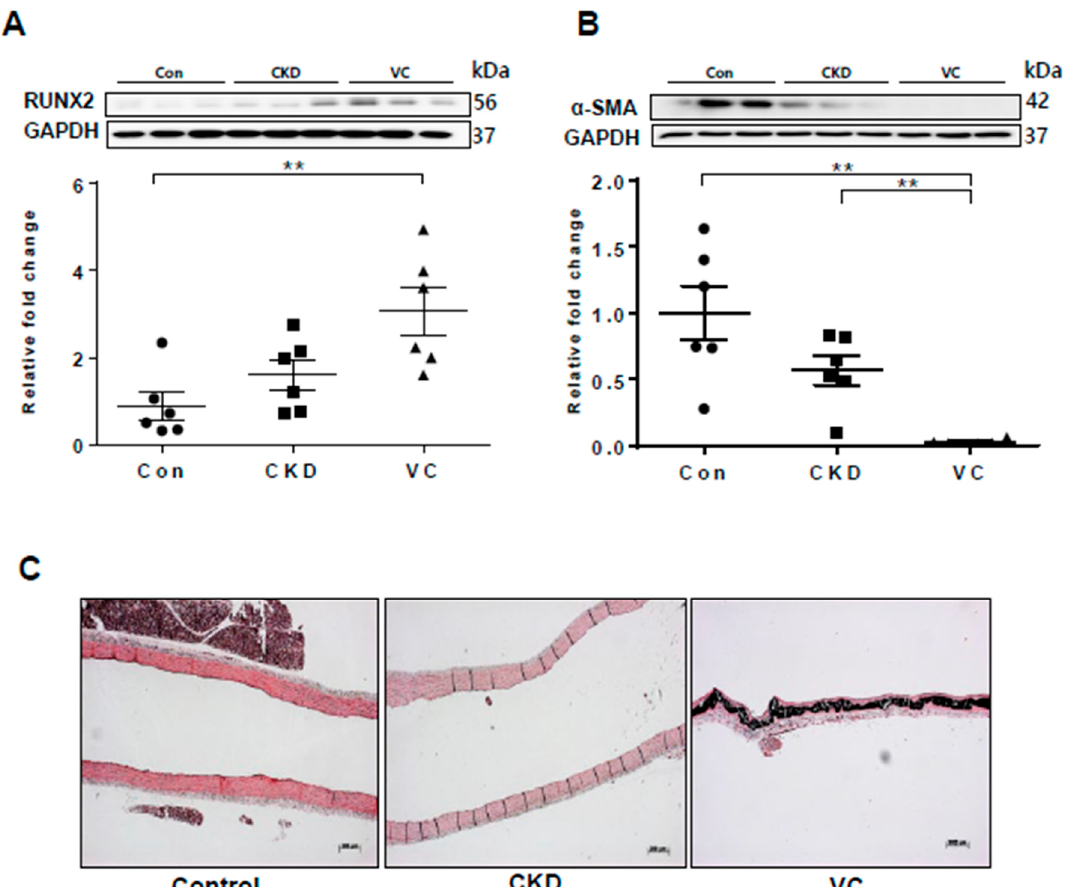
Figure 6. Vascular calcification (VC) was induced in a rat model of adenine-induced chronic kidney disease (CKD). For each model, six rats were included. The protein levels of RUNX2 and α –smooth muscle actin ( α -SMA) in rats with adenine-induced CKD were examined using Western blotting; three representative results from each group are presented. VC was confirmed by von Kossa staining of rat aortas. ( A ) The expression of RUNX2 was significantly increased in the CKD with VC group compared with the control group; ( B ) The expression of α -SMA was decreased in the CKD with VC group; ( C ) VC was confirmed by von Koss staining of rat aortas. Scale bar, 200 µ m. Data are expressed as mean ± standard errors of the means from six independent experiments. * p < 0.05, ** p < 0.01.